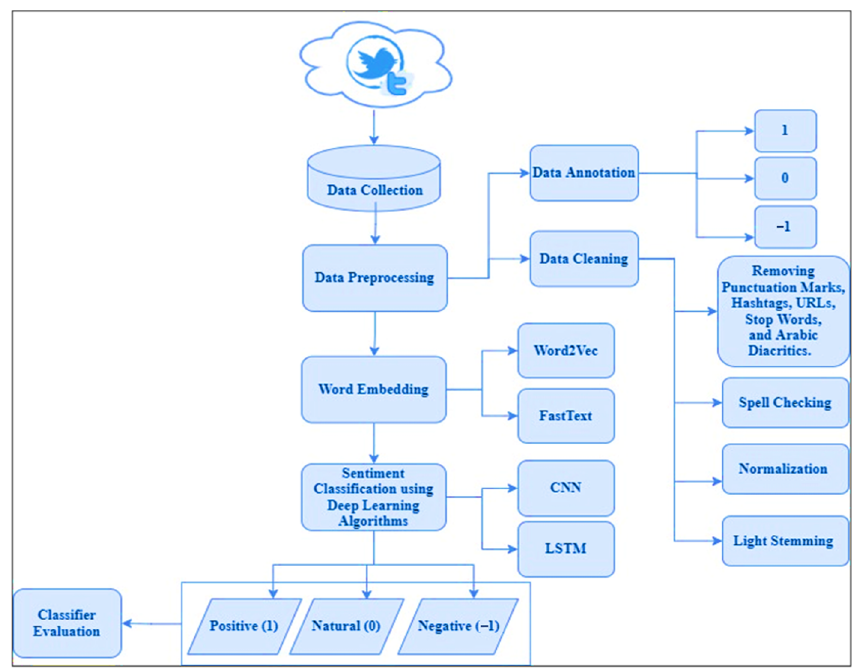
Figure 1. The proposed methodology of Arabic sentiment analysis.